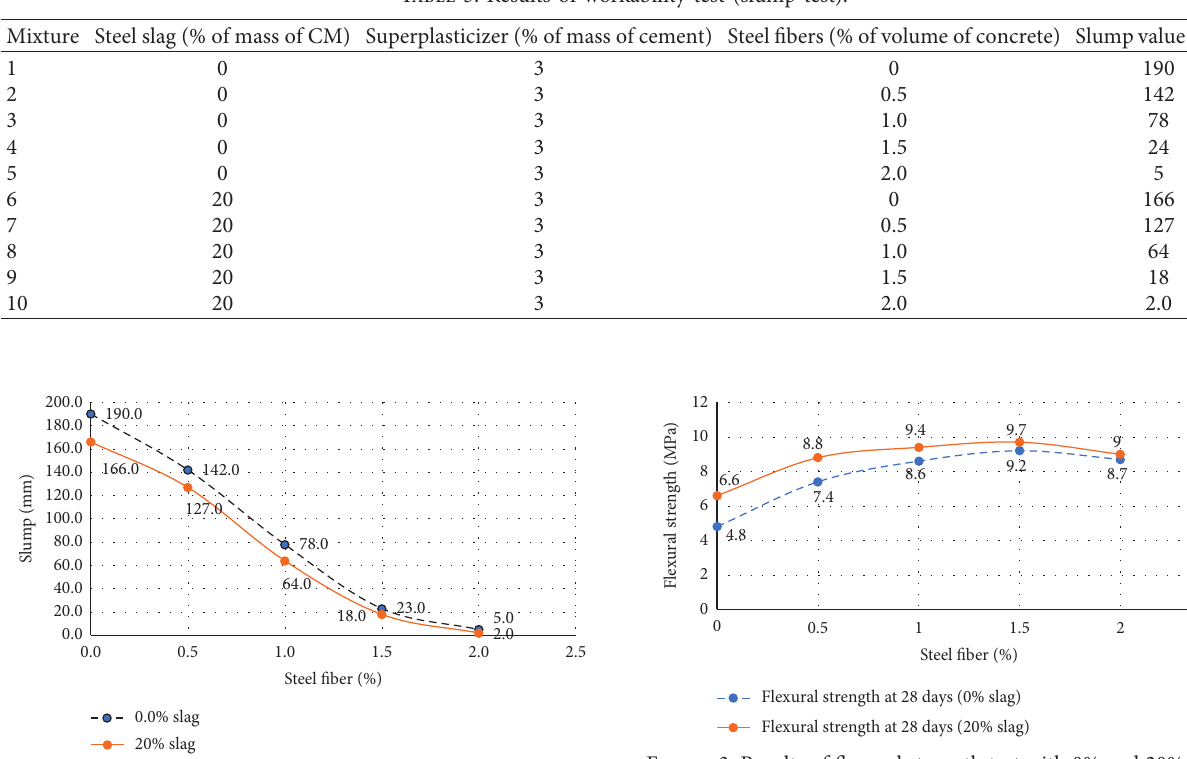
Table 5: Results of workability test (slump test).